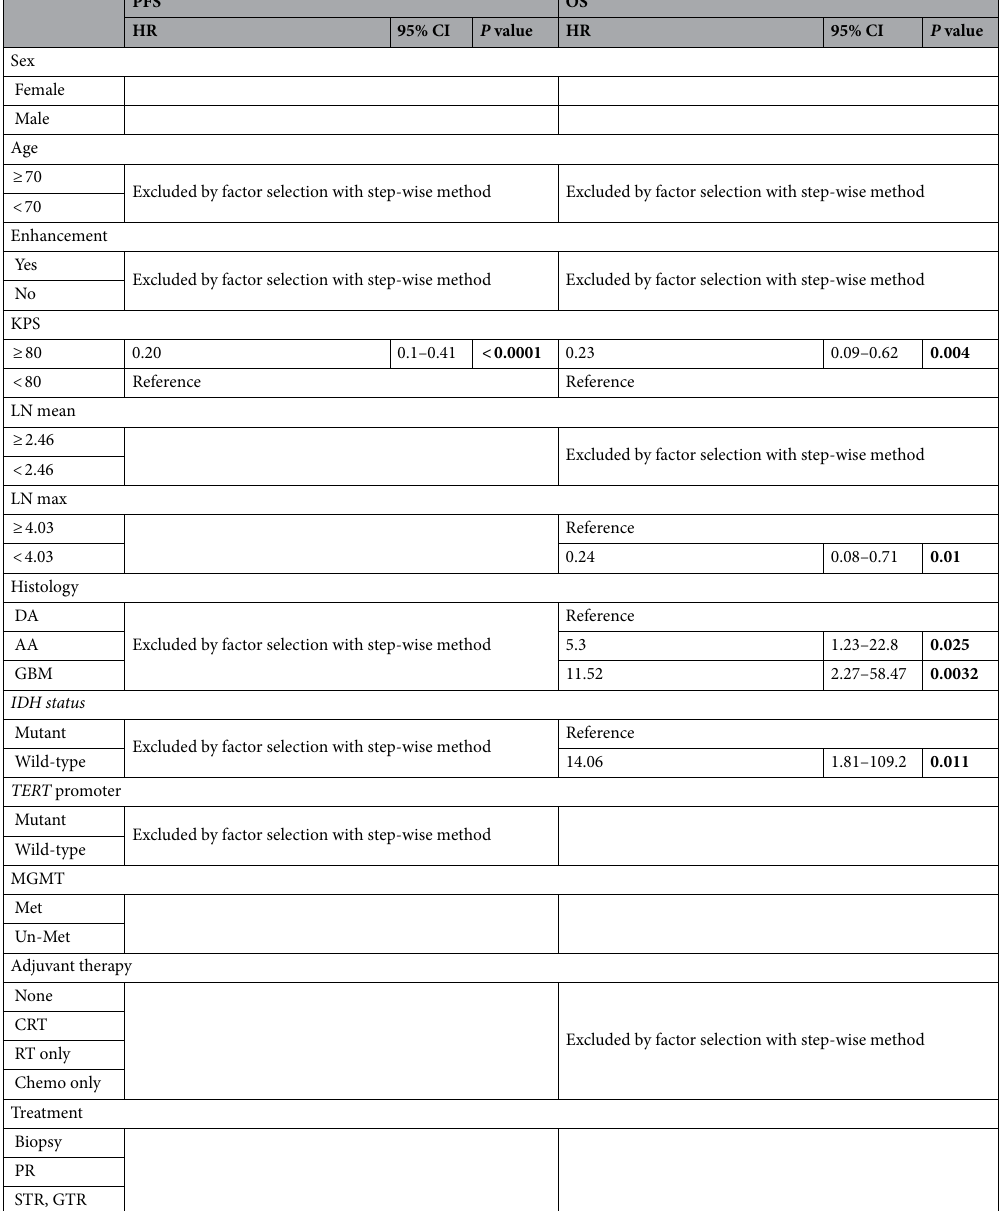
Table 3. Prognostic factors for PFS, and OS in the multivariate analyses KPS Karnofsky performance status, LN lesion-to-contralateral normal brain tissue, DA diffuse astrocytoma, AA anaplastic astrocytoma,